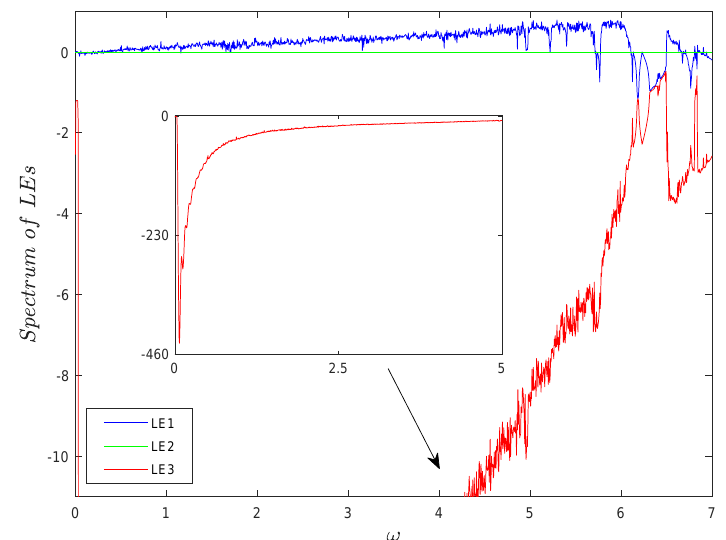
Figure 4. The Lyapunov exponent spectrum of VdPVP (Van der Pol oscillator with variable parameter) with respect to parameter ω when ρ = 0.6, k = 19.5. (The blue line represents the positive Lyapunov exponent, the green line represents the zero Lyapunov exponent, and the red line represents the negative Lyapunov exponent).